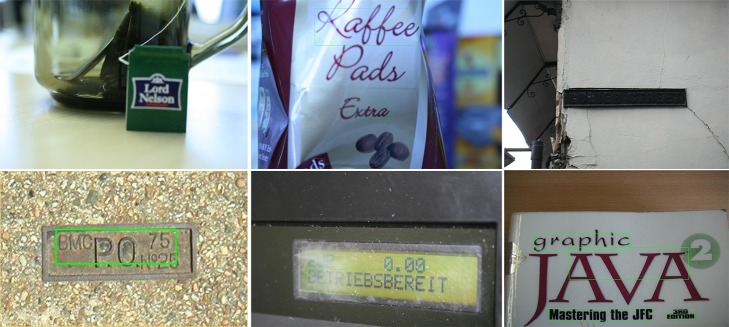
Unsuccessful samples on the ICDAR dataset [17, 53].